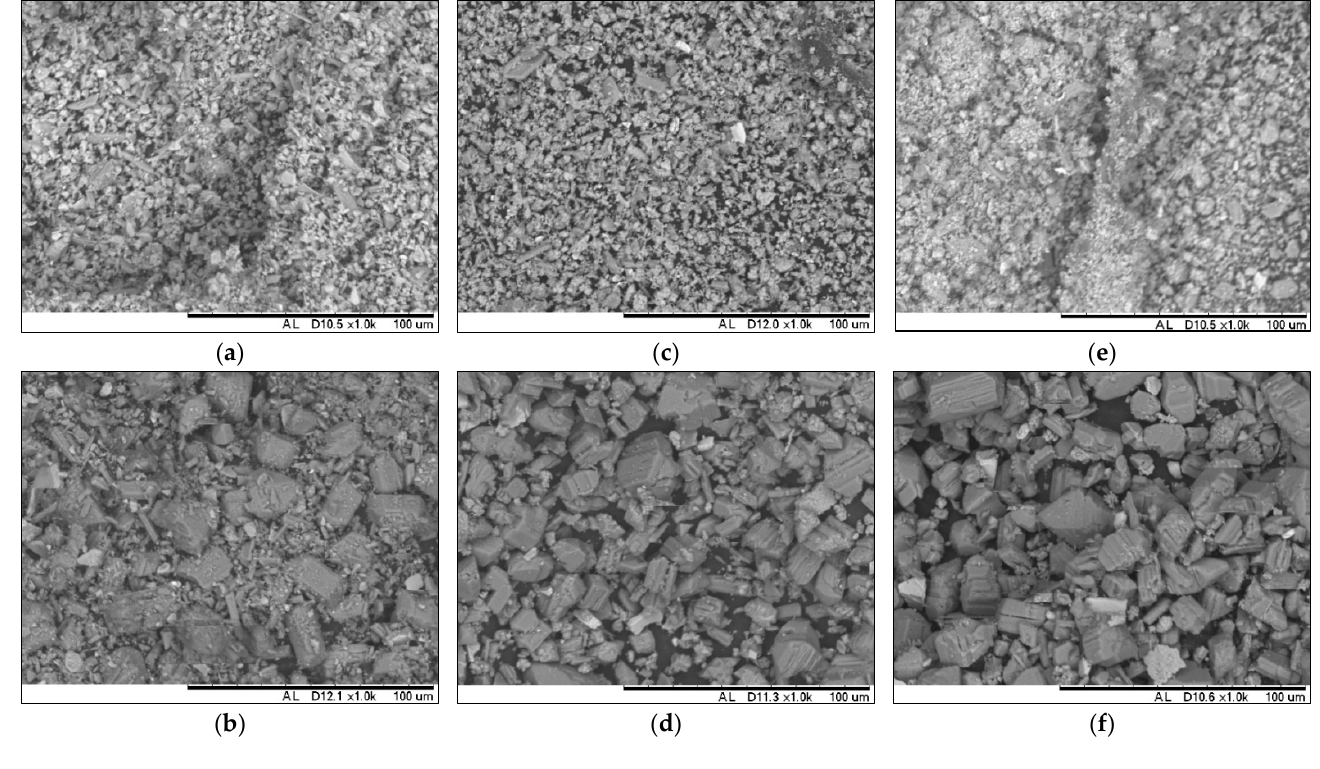
Figure 7. SEM images of the as-synthetized products: ( a ) 0.1 M-WA, ( b ) 0.1 M-WB, ( c ) 0.5 M-WA, ( d ) 0.5 M-WB, ( e ) 1.0 M-WA, and ( f ) 1.0 M-WB.